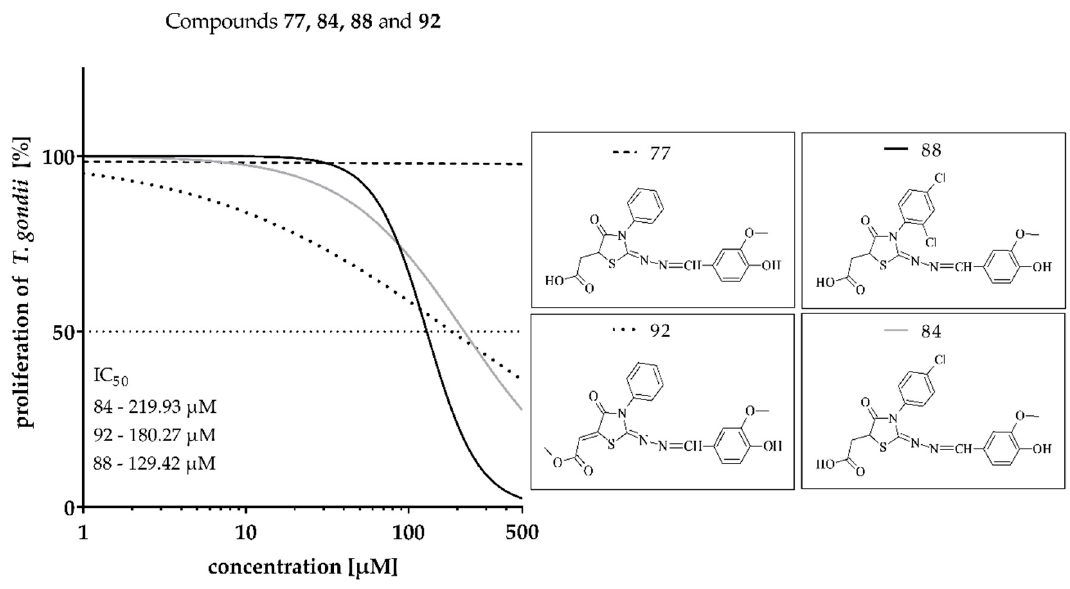
Figure 2. Dose response curves and IC 50 values ( µ M) of 77 , 84 , 88 , and 92 on T. gondii tachyzoites proliferation.